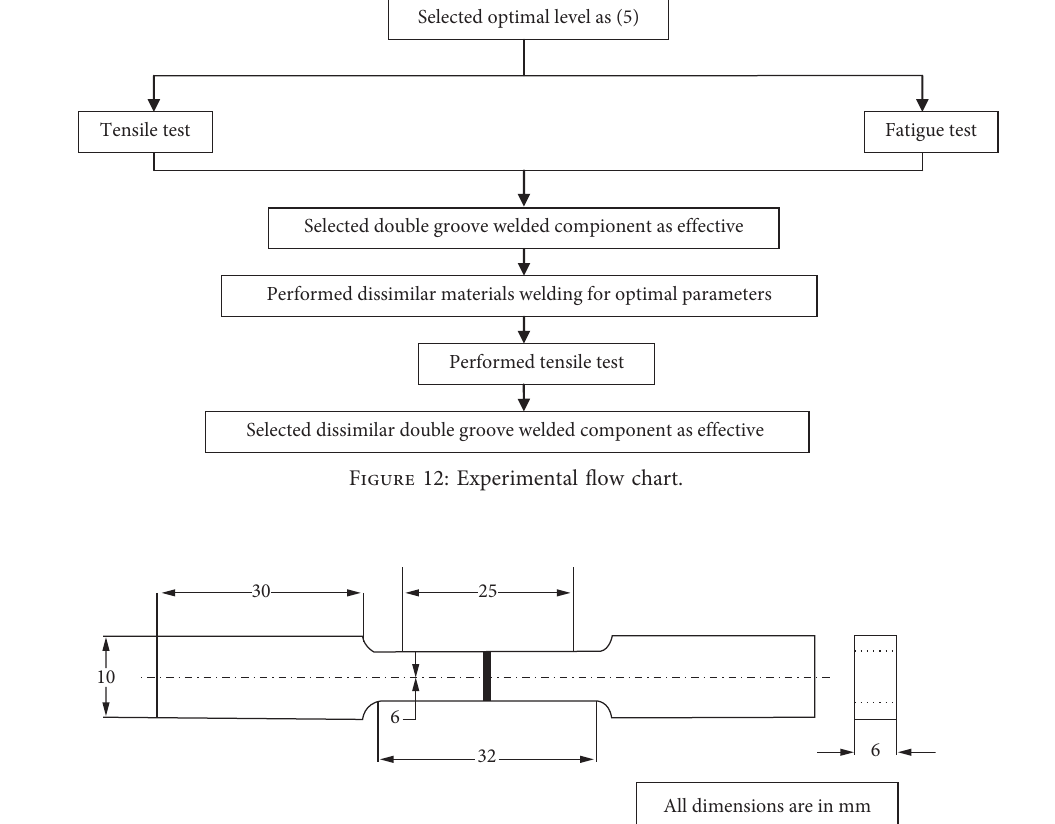
Figure 13: Tensile specimen according to ASTM